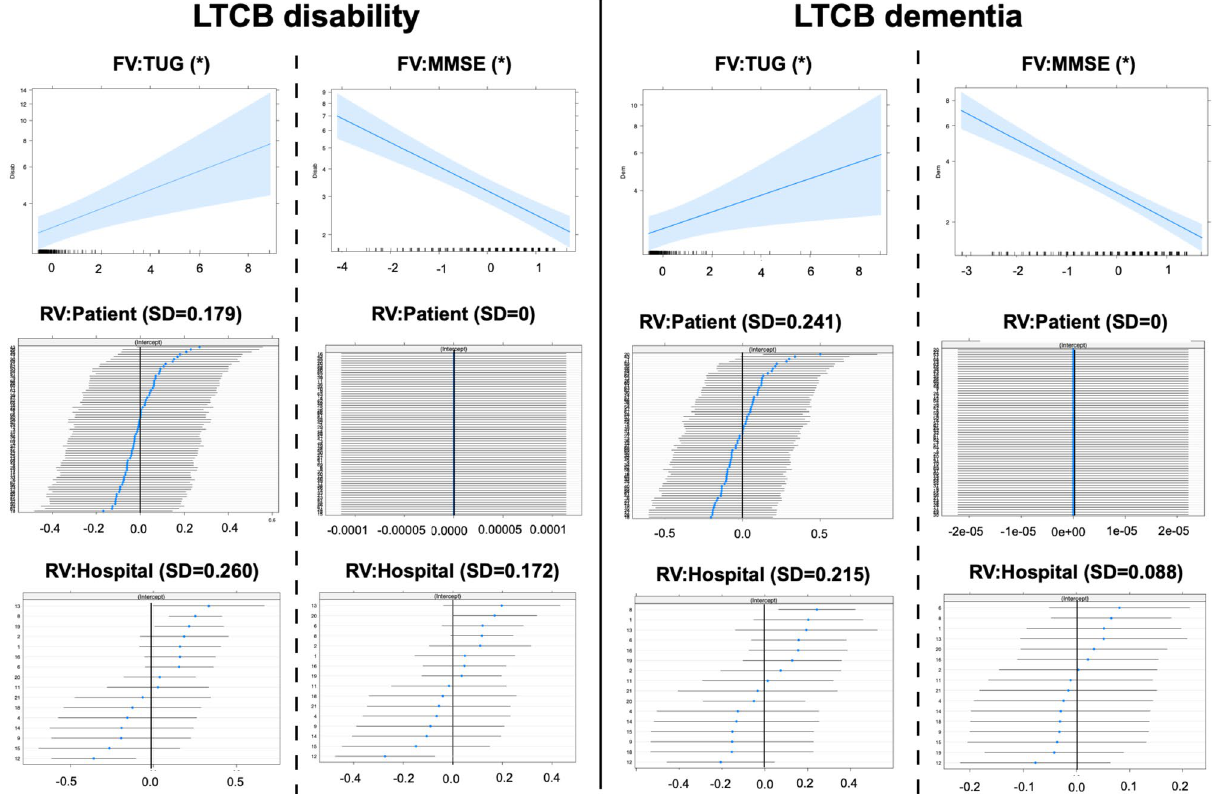
Figure 5. Changes in LTCB grades in TUG and MMSE. As the LTCB grades (disability: left, dementia: right) increased, TUG (upper left) increased and MMSE (upper right) decreased at statistically significant levels. The shaded area represents a pointwise confidence interval for the fitted values. Confidence intervals of random variables (middle and lower) revealed that most patients were at zero and some specific hospitals were below or above